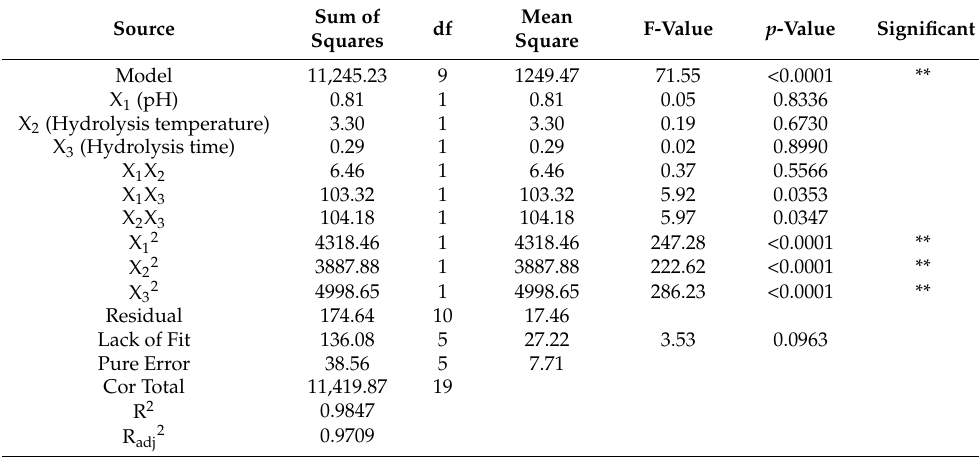
Table 5. Analysis of variance